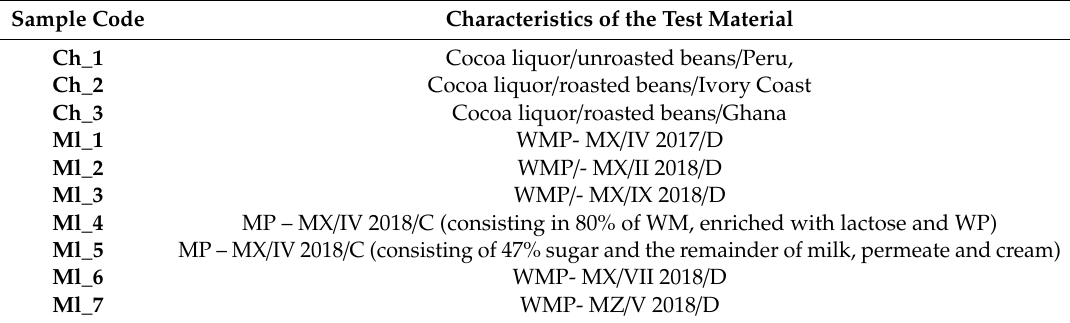
Table 2. List and marking of raw materials used to prepare chocolate milk masses.